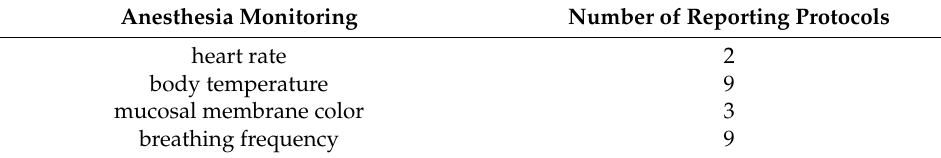
Table 3. Anesthesia monitoring. Anesthesia